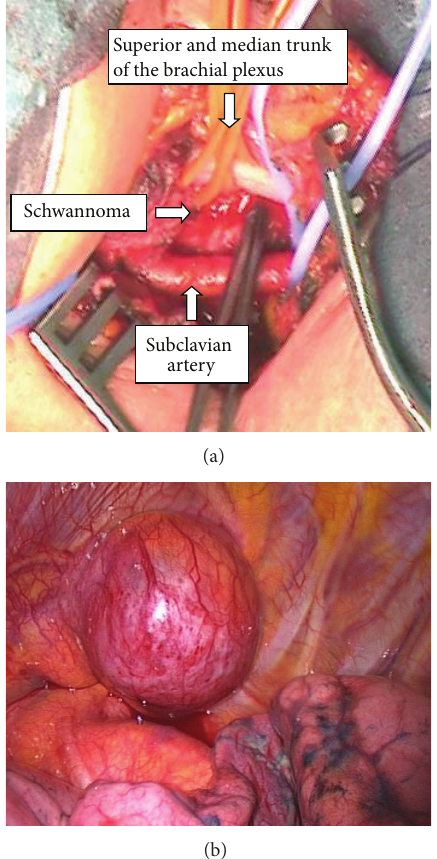
Figure 4: ((a) and (b)) Cervical and videothoracoscopic access. The surgical approach was defined as a one-stage combined supr- aclavicular incision (a) followed by left video-assisted thoracoscopic surgery